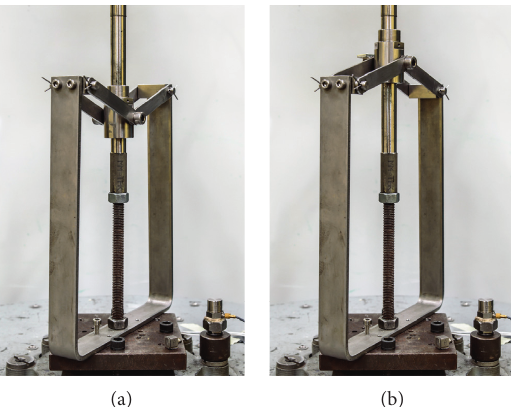
Figure 6: Photos of the experimental setup: (a) negative equilibrium position z ∗